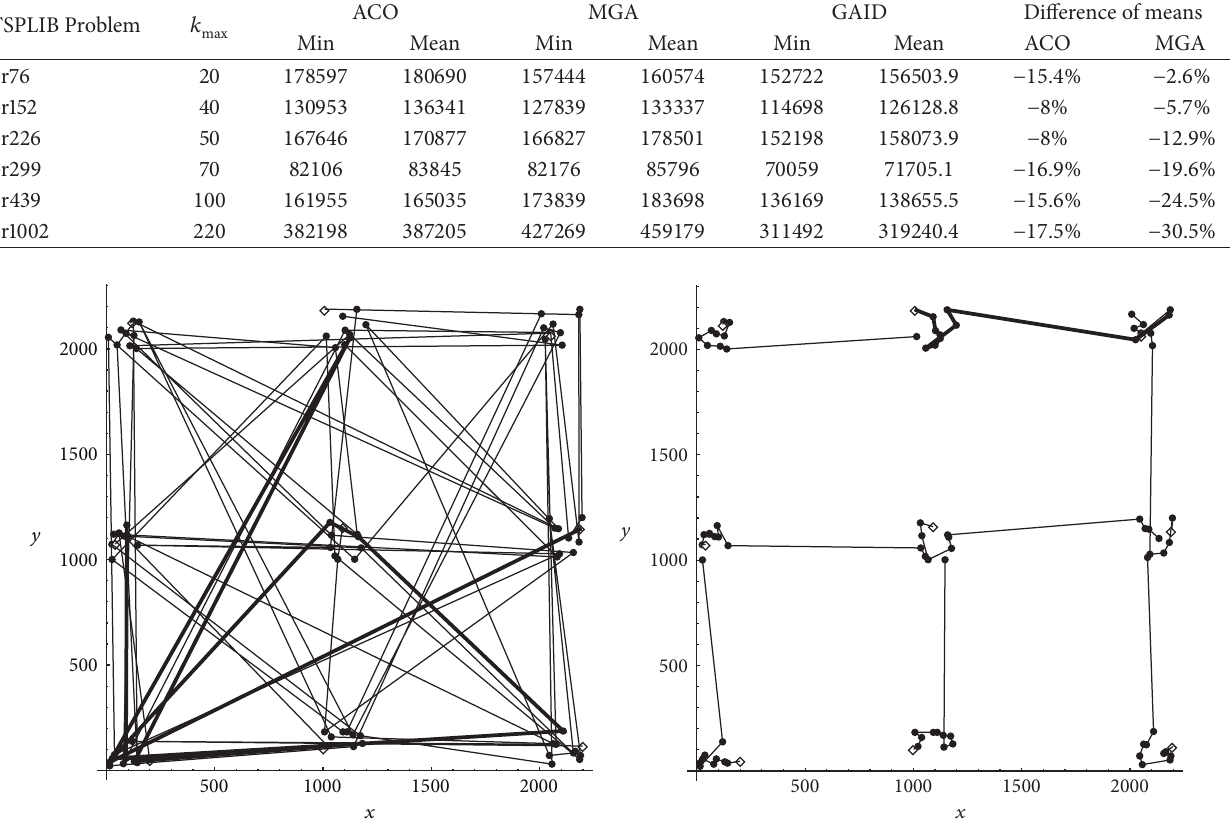
Figure 3: The GAID algorithm was tested on a MAPP which contains 81 targets forming 9 clusters on a 2200 × 2200 square domain. An agent was placed into each cluster (white diamonds); thus the number of agents is 𝑚 = 9 . The initial cost based on (9) is 15302.3 for random and 1627.9 for greedy initialization. The longest subtour is highlighted with thick